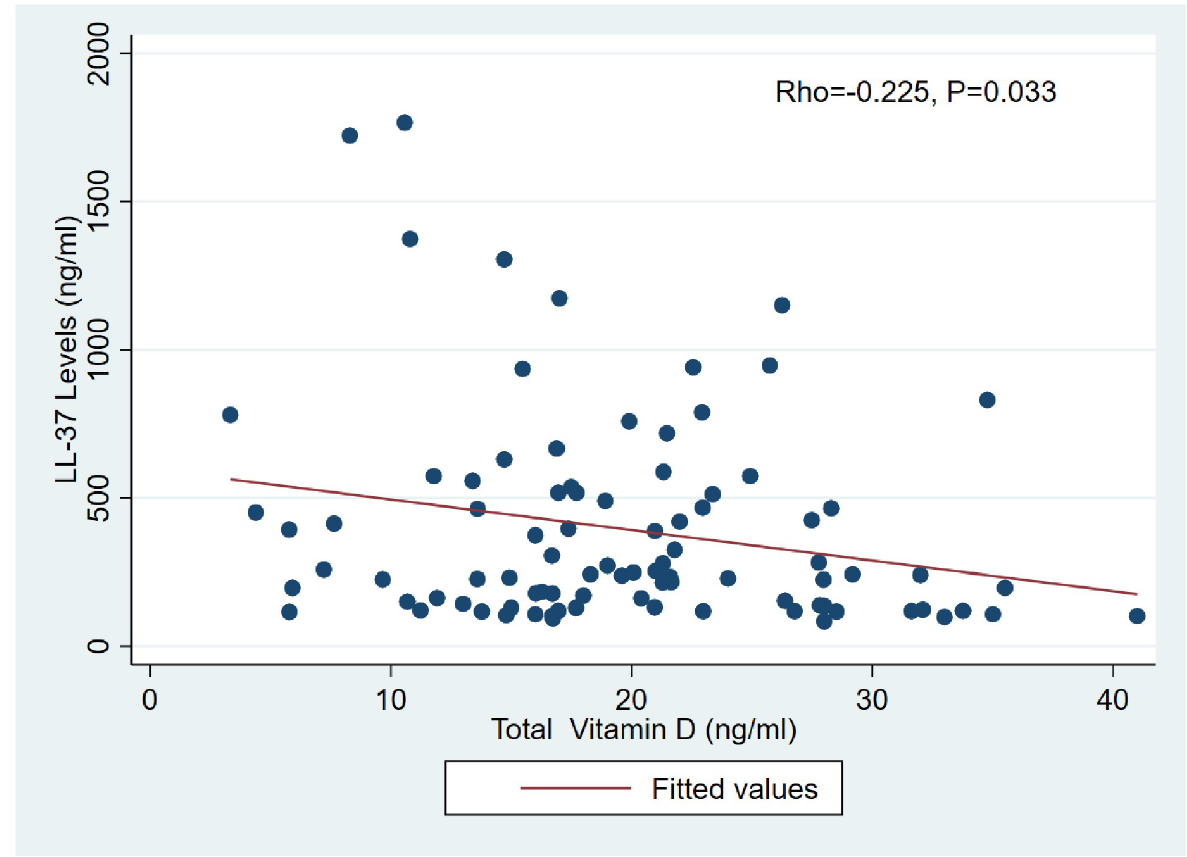
Fig 3. Correlation of LL-37 and total vitamin D levels in ATB patients, LTBI, and those without TB infection.